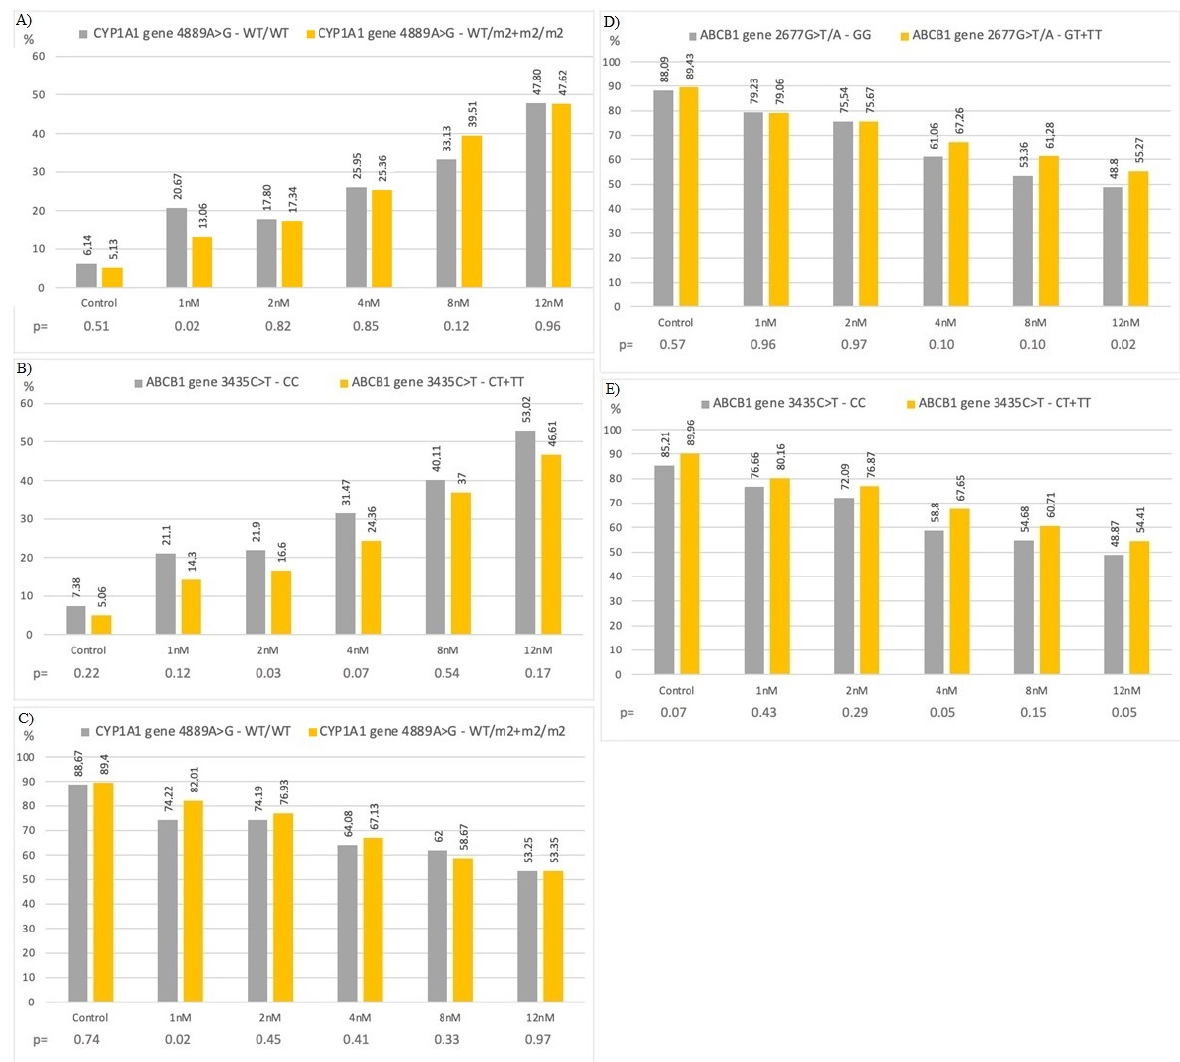
Figure 6. Bortezomib in vitro study. Number of: ( A ) apoptotic cells with CYP1A1 4889A > G genotypes; ( B ) apoptotic cells with ABCB1 3435C > T genotypes; ( C ) viable cells with CYP1A1 4889A > G genotypes; ( D ) viable cells with 2677G > T/A genotypes; ( E ) viable cells with ABCB1 3435C > T genotypes.